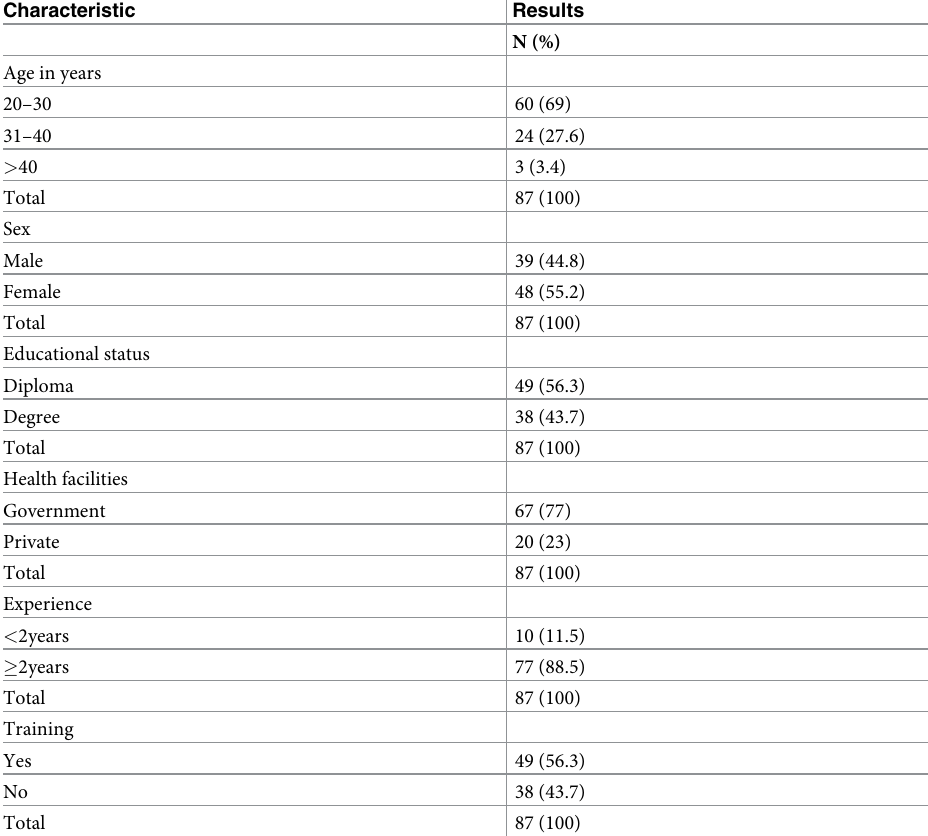
Table 1. Socio-demographic characteristics of laboratory professionals at health facilities in Bahir Dar city administration from January to March 2017.